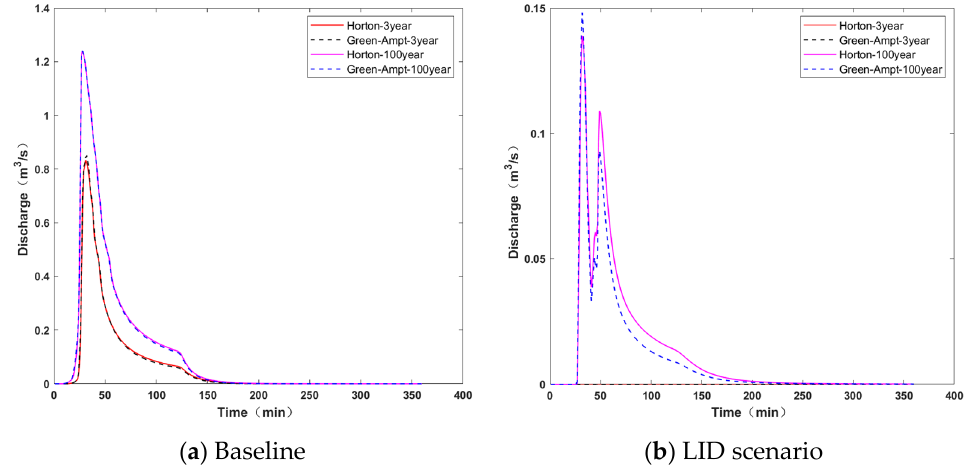
Figure 7. Hydrographs of the outlet in 3-yr and 100-yr design storms, simulated by the different infiltration methods in the baseline ( a ) and LID scenario ( b ).